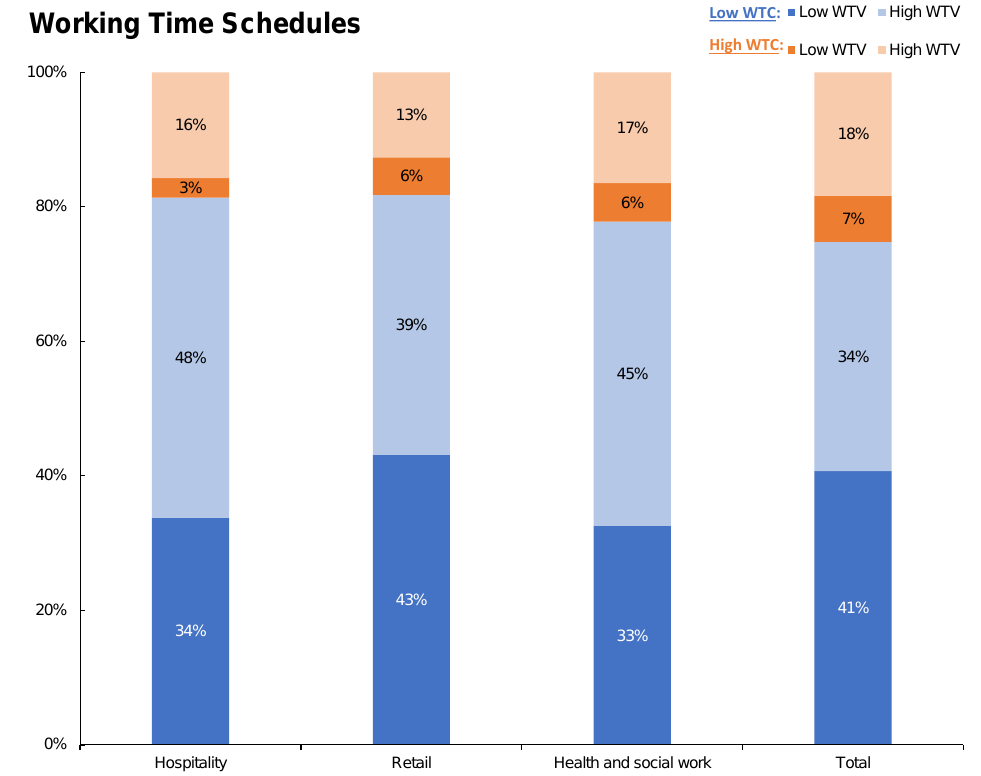
Figure 3. Distribution of working time schedules (WTC and WTV) across selected occupational sectors, weighted by cross-national weights for the EU28, WTC: working time control, WTV: working time variability.